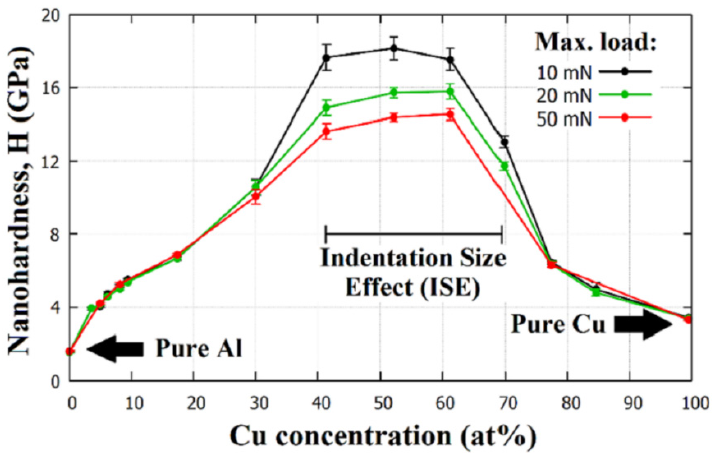
Figure 10. Result of nanoindentation measurements determined from the micro-combinatorial sample: nano-hardness values of the AlCu thin film system as a function of Cu alloying concentration. Reproduced with permission from [40]. Copyright © 2022, Elsevier.